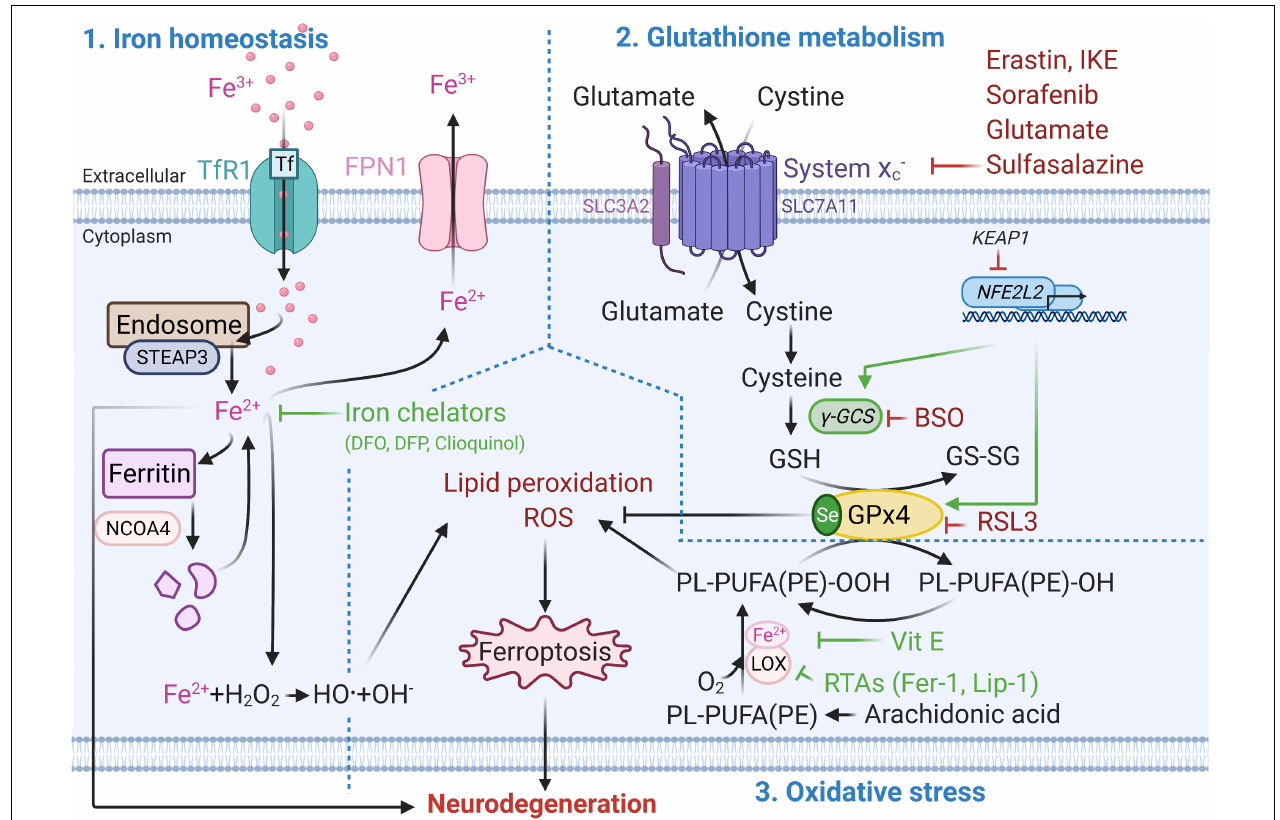
FIGURE 1 | Molecular mechanisms of ferroptotic cell death. Metabolic pathways such as iron metabolism (left), cysteine and glutathione metabolism (top right), and polyunsaturated fatty acid metabolism (bottom right) play an essential role in the ferroptotic pathway. Well established ferroptosis inducers and inhibitors and their mode of action are depicted in red and green respectively. BSO, Buthionine sulphoximine; DFO, Deferoxamine; DFP, Deferiprone; Fe2 +, Ferrous iron; Fe3 +, Ferric iron; FPN1, Ferroportin; GPx4, Glutathione peroxidase 4; GSH, Glutathione (reduced glutathione form); GS-SG, Glutathione disulfide (oxidized glutathione form); Keap1, Kelch-like ECH-associated protein 1, LOX, Lipoxygenase; NCOA4, Nuclear receptor co-activator 4; NFE2L2, nuclear factor E2 related factor 2 encoding for Nrf2; PL-PUFA(PE)-OH, Polyunsaturated-fatty-acids (phosphatidylethanolamine)-reduced; PL-PUFA(PE)-OOH,